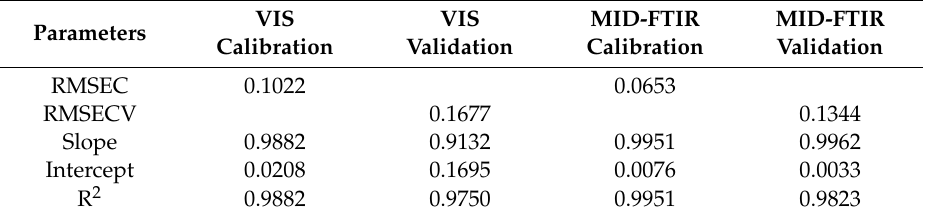
Table 2. Statistical parameters associated with the accuracy of the developed methods.